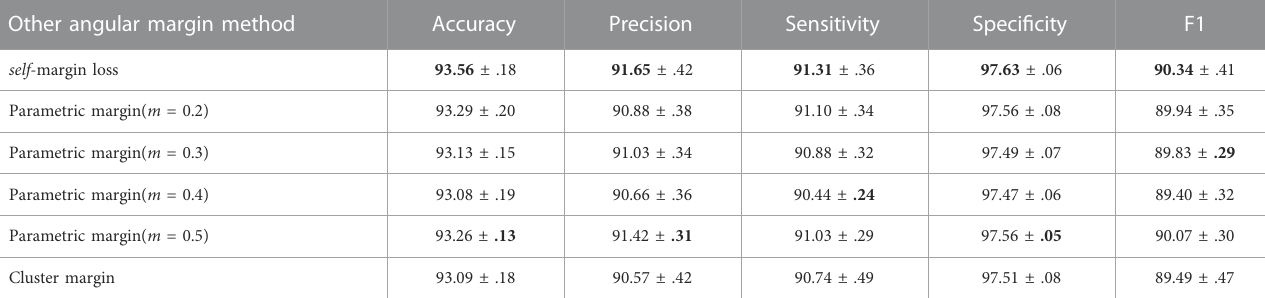
TABLE 6 Other candidate angular margin based scenarios and the main differences are detailed in Section 3.5.4. Other angular margin method